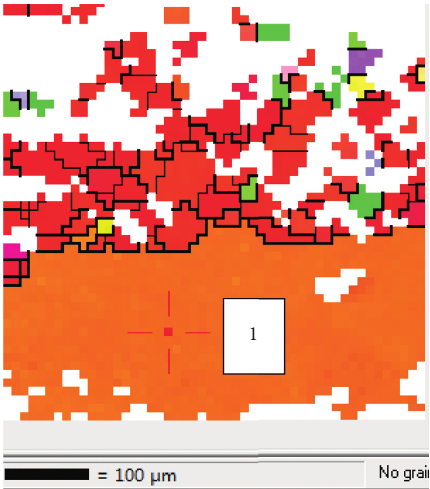
Figure 10: The point for Euler angle analysis.